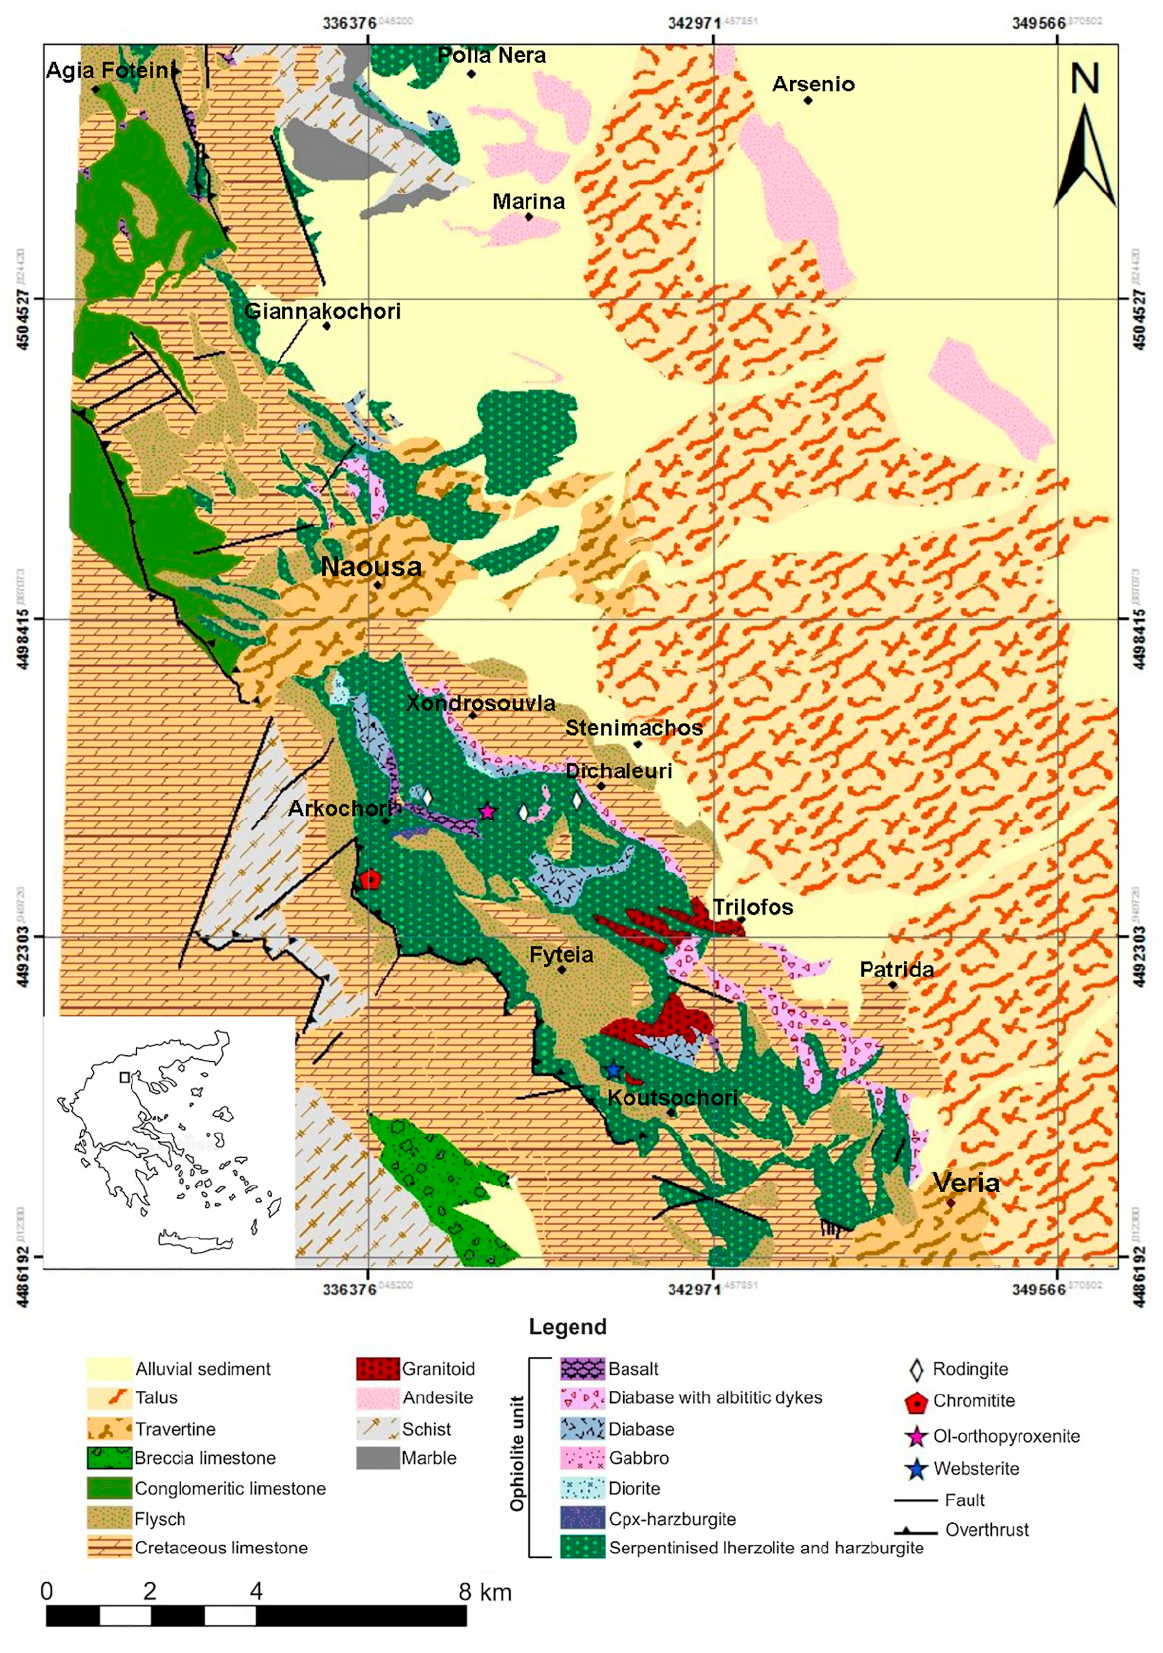
Figure 1. Geological map of the Veria sheet IGME [54,57] (modified after fieldwork and mapping by using ArcMap 10.1); the black rectangle in the inset shows the study area.